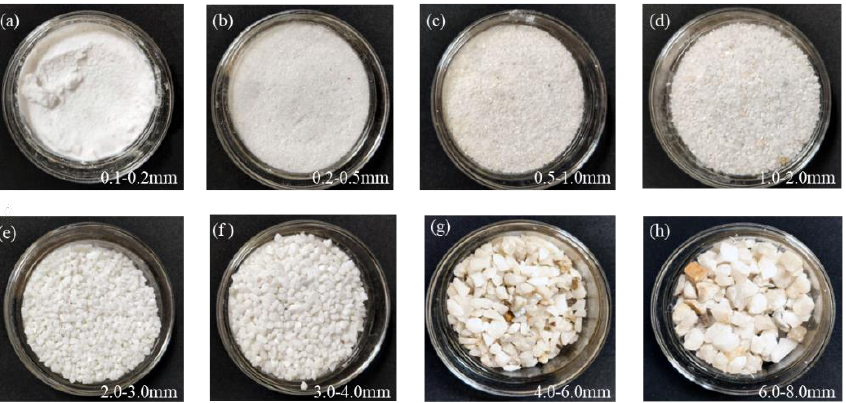
Figure 1. Sand of samples with different grain size grades. ( a ) 0.1 – 0.2 mm; ( b ) 0.2 – 0.5 mm; ( c ) 0.5 – 1 mm; ( d ) 1 – 2 mm; ( e ) 2 – 3 mm; ( f ) 3 – 4 mm; ( g ) 4 – 6 mm; ( h ) 6 – 8 mm. ( d ) 1–2 mm; ( e ) 2–3 mm; ( f ) 3–4 mm; ( g ) 4–6 mm; ( h ) 6–8